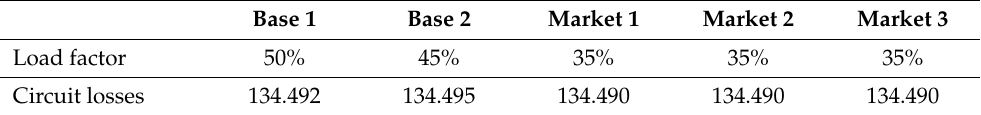
Table 4. Transformer Load Factor and circuit losses for different